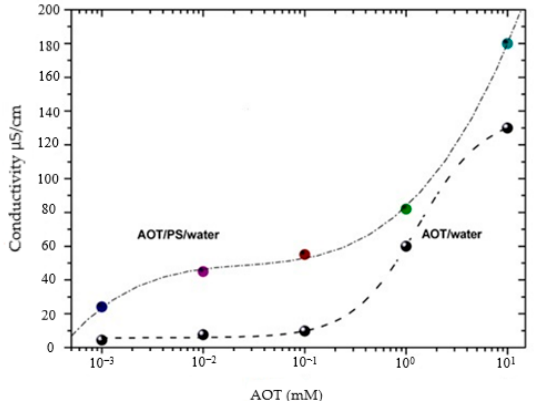
Figure 2. Conductivities of the AOT/water and PS/AOT/water systems. The conductivity of deionized water as the measured background was less than 0.1 µs/cm. The AOT concentration ranged from 0.001 to 10 mM. AOT: Sodium di-2-ethylhexylsulfosuccinate; PS: Polystyrene.